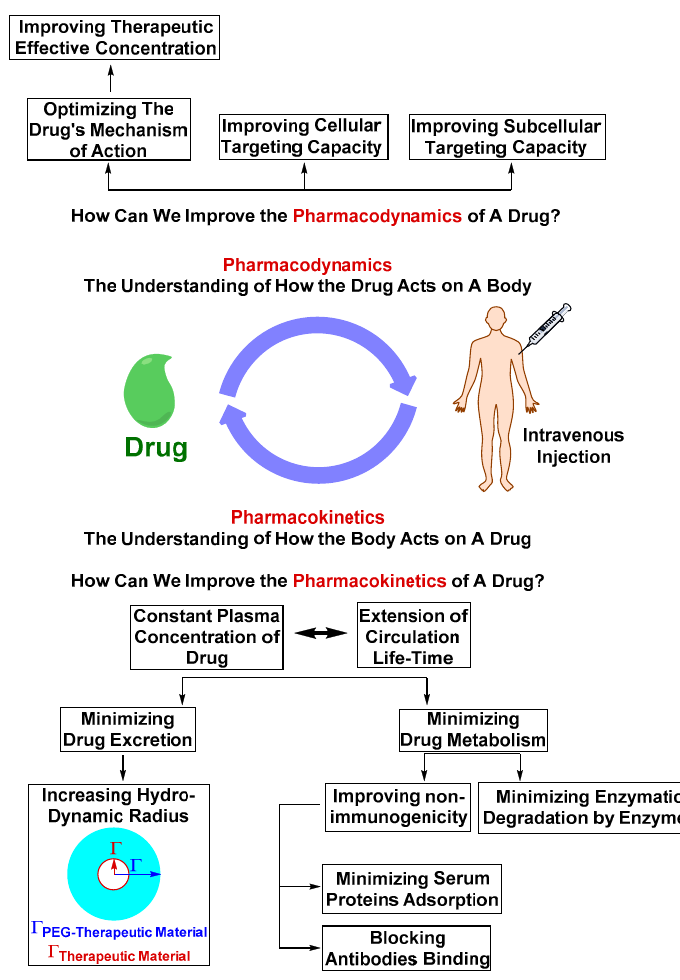
Figure 20. The pharmacokinetics and pharmacodynamics aspects that determine the fate of